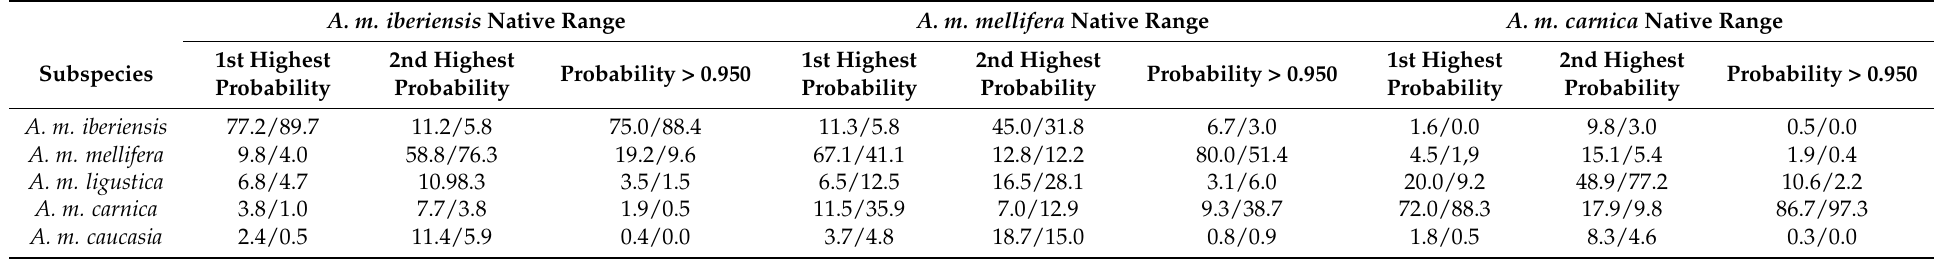
Table 1. Percentages of wings/colonies classified by DeepWings© into each one of the five subspecies according to the origin of the samples (native ranges of A. m. iberiensis , A. m. mellifera, and A. m. carnica ). Percentages are shown for the top two classification probabilities and considering a probability threshold >